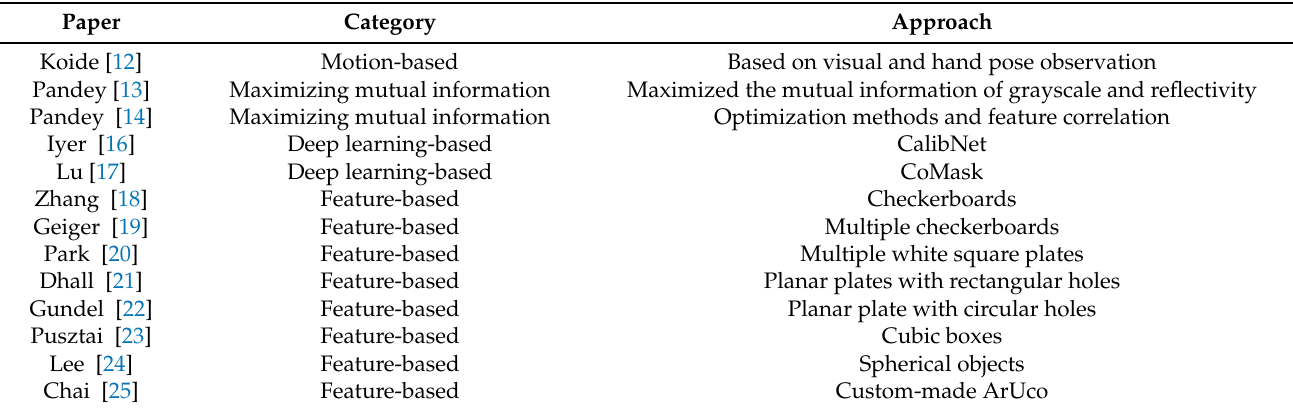
Table 1. Classification of main calibration